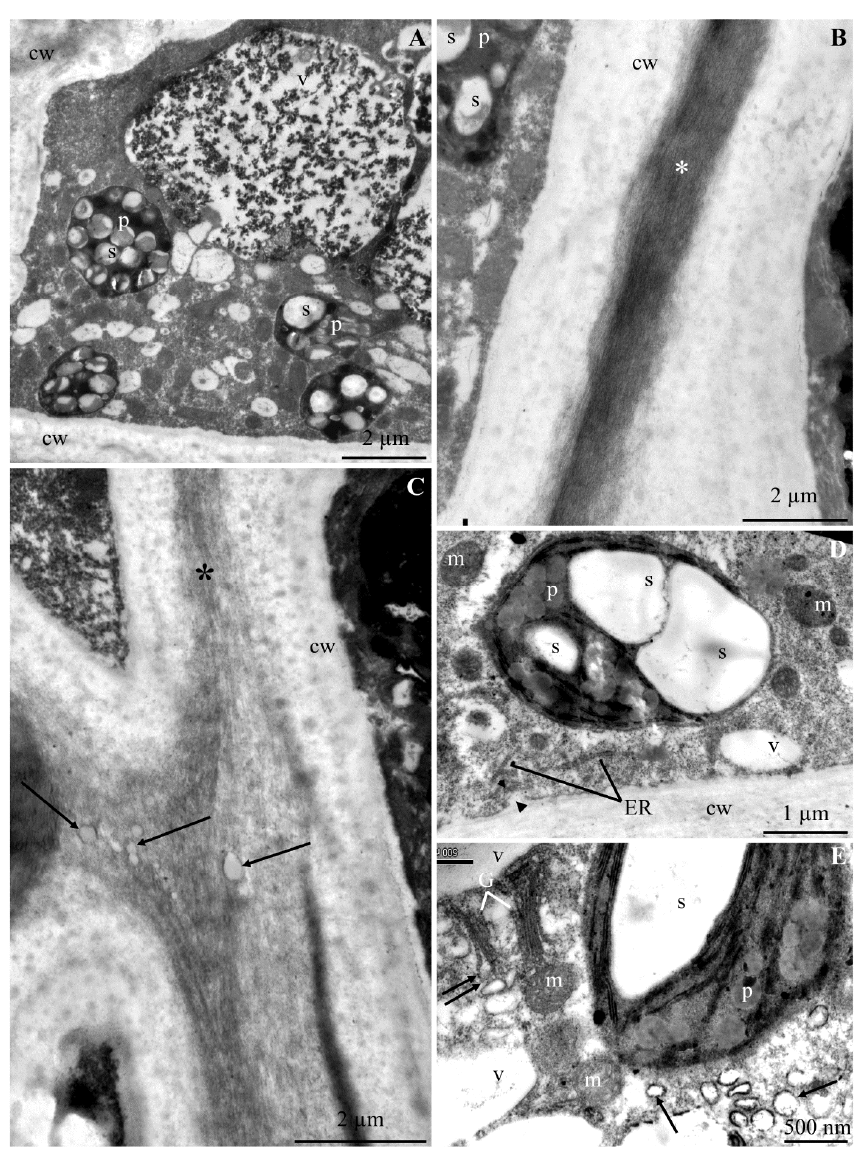
Figure 6. Fragments of the cross sections of epidermis cells from the apical part of ‘Szampion’ apples from the EDTA-chelated Ca foliar feeding treatments. A : cell wall, electron dense cytoplasm, plastids (p) with starch grains (s), vacuole (v), flocculent substance in the cell sap. B , C : cell wall (cw), visible middle lamella (asterisk), numerous transport vesicles in the cell wall (arrow) (Figure 6C), plastid (p) with starch grains (s) (Figure 6B). D , E : cell wall (cw) (Figure 6D), amyloplast (p) with starch grains (s), numerous mitochondria (m) located around the plastid, endoplasmic reticulum (ER) (Figure 6D), plasmalemma invagination (arrowhead) (Figure 6D), Golgi apparatus (G) with dictyosomal vesicles (two arrows) (Figure 6E), transport vesicles (arrow) (Figure 6E).